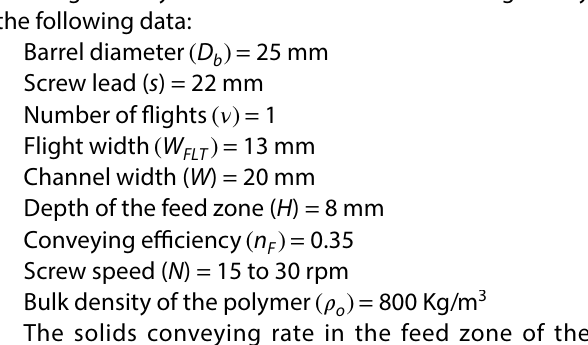
Fig. 10b. Adjusting the spiral screw rotation speed adjusts the amount of liquid ejected.